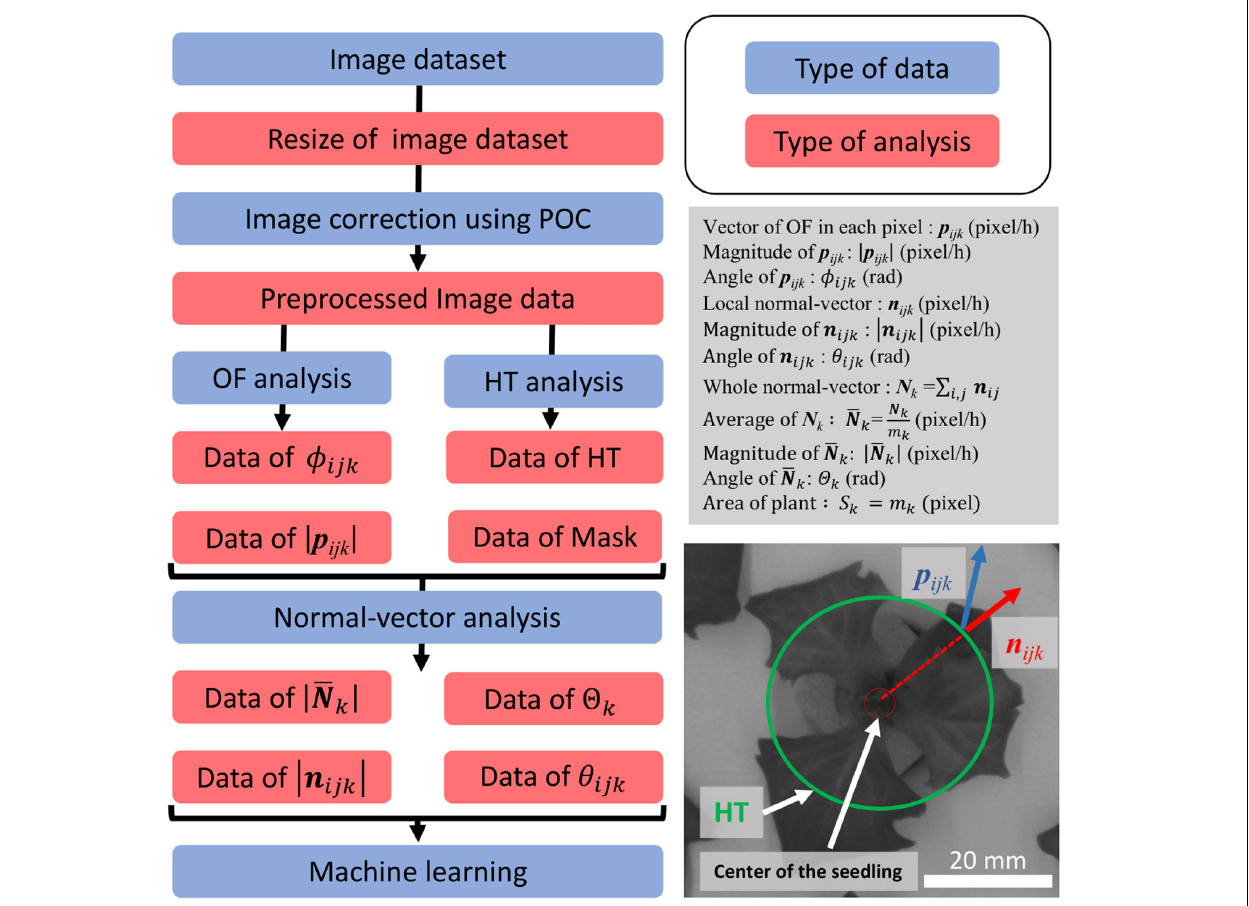
FIGURE 2 | Summary of analyses performed, and conceptual drawing of normal-vector analysis. The flowchart on the left shows the preprocessing process for the dataset. The process with the blue background shows the type of data which were focused, and the red background shows the type of analysis method used for preprocessing. The description in the gray box shows the definition used in this study. The image on the bottom right shows the concept of our study. The green circle shows the detection of the panel using HT. The blue vector is the OF vector, and the red circle shows the local-normal